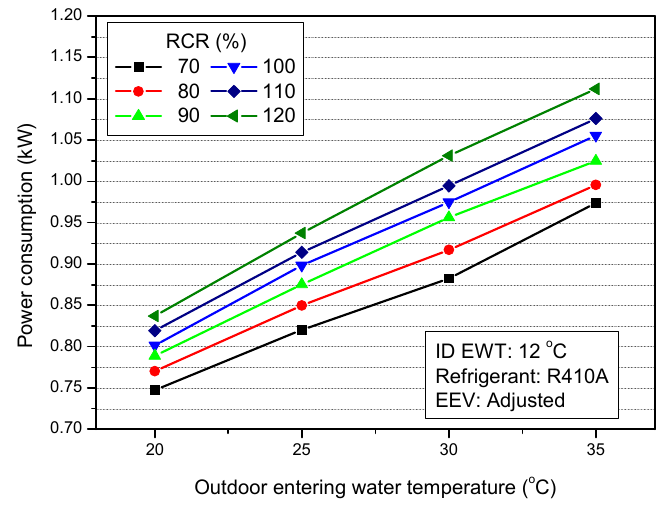
Figure 12. Variation of power consumption with T OD in cooling mode.